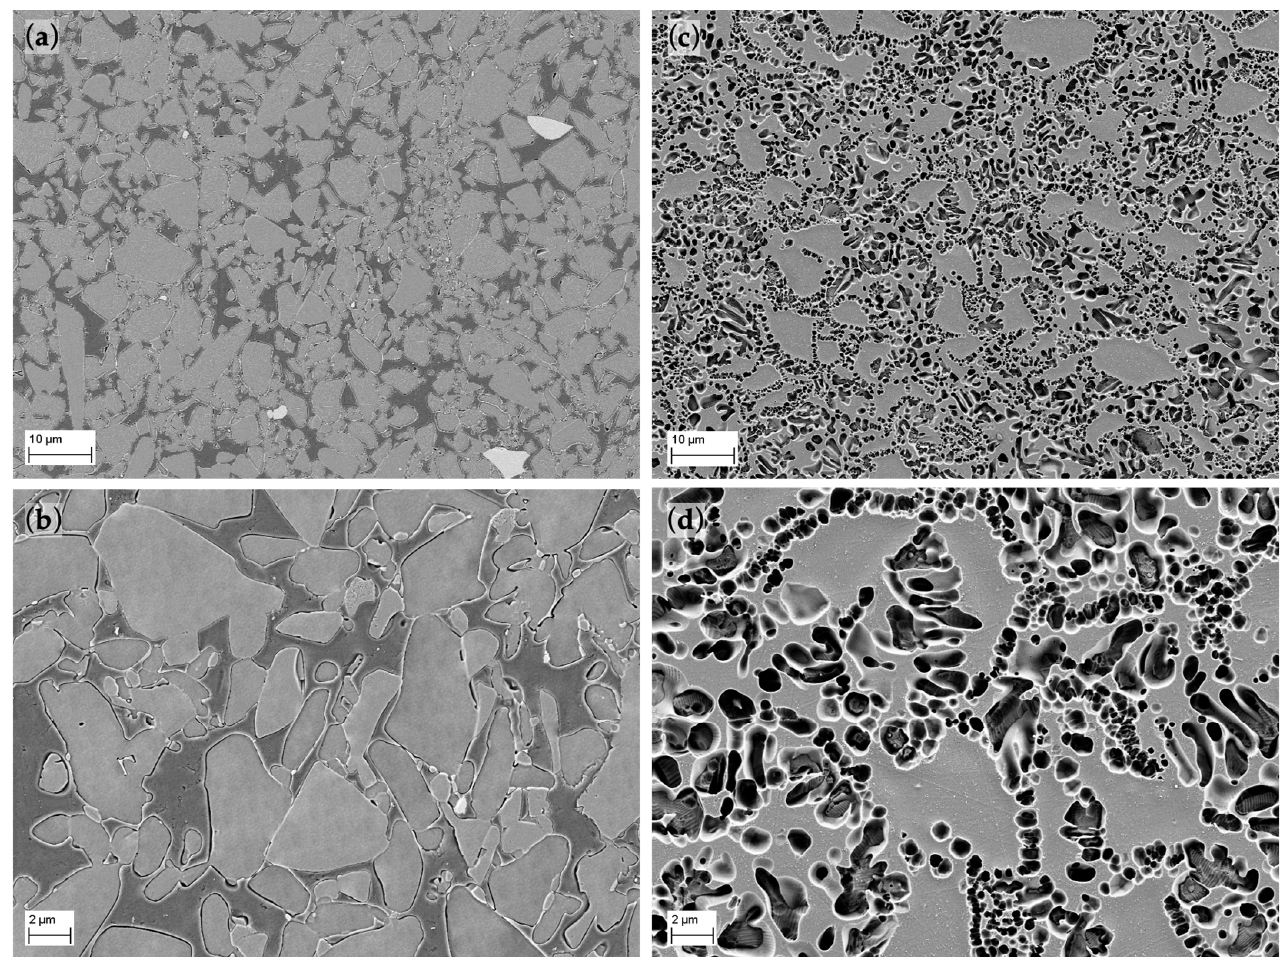
Figure 4. FESEM micrographs of polished and etched surfaces of ( a , b ) VE and ( c , d ) EC materials.